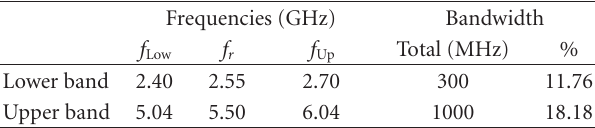
Table 3: Frequency bands and bandwidths for dual-band hexagonal